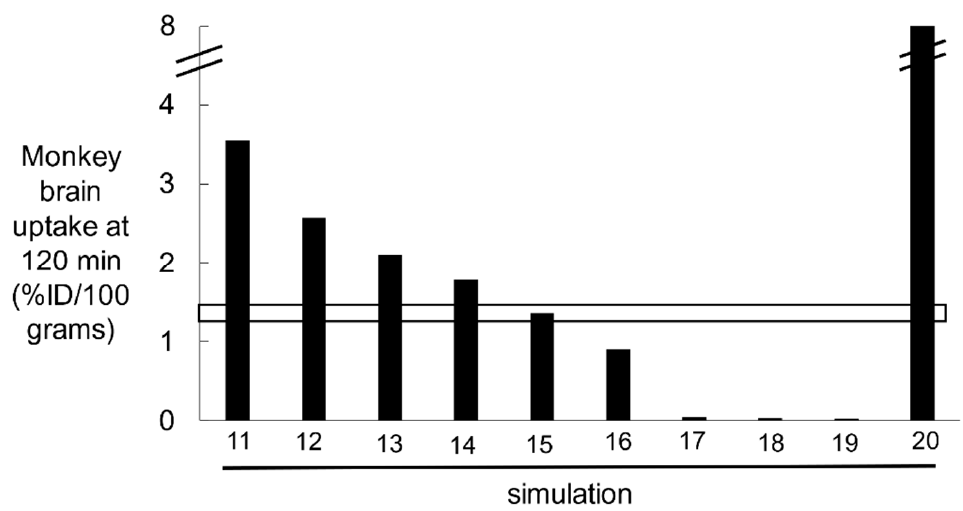
Figure 6. The brain HIRMAb-IDUA fusion protein uptake values, expressed as a percent of injected dose (ID) per rhesus monkey brain (100 g), at 120 min following an IV administration of 0.1 mg/kg of the HIRMAb-IDUA fusion protein are shown for simulations 11–20. The 120 min HIRMAb-IDUA fusion protein concentrations, in units of nM, are given in Table 8. The brain HIRMAb-IDUA fusion protein concentration (nM) is converted to %ID/100 g, based on the ID, 0.38 mg (1.3 nmol), in the 3.8 kg monkey, the volume of the brain ECS (39), and the weight of the rhesus monkey brain, 100 g [16]. The experimentally determined uptake by the brain of the HIRMAb-IDUA fusion protein, at this ID, in the Rhesus monkey has been reported previously [16], and the mean ± SE of this observed uptake is given by the open horizontal bar.